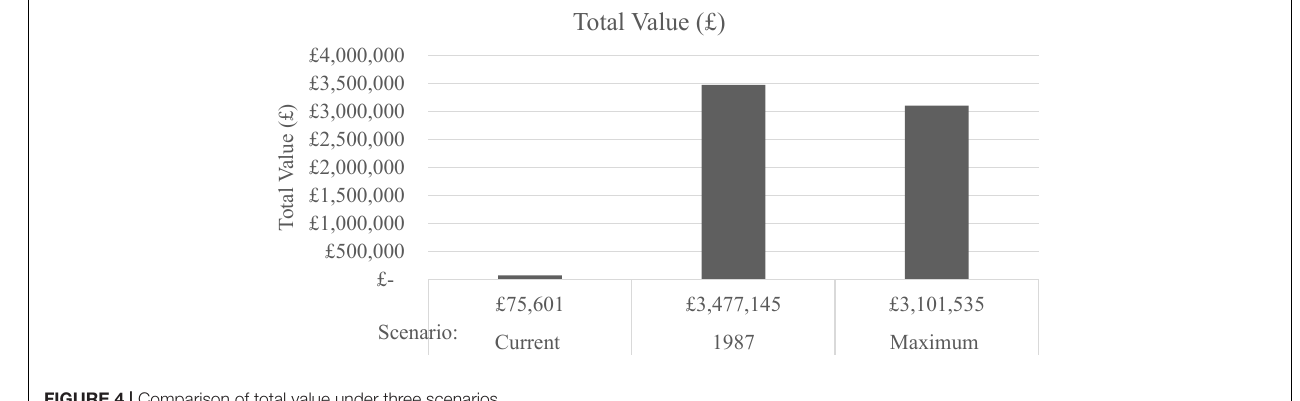
FIGURE 4 | Comparison of total value under three scenarios.